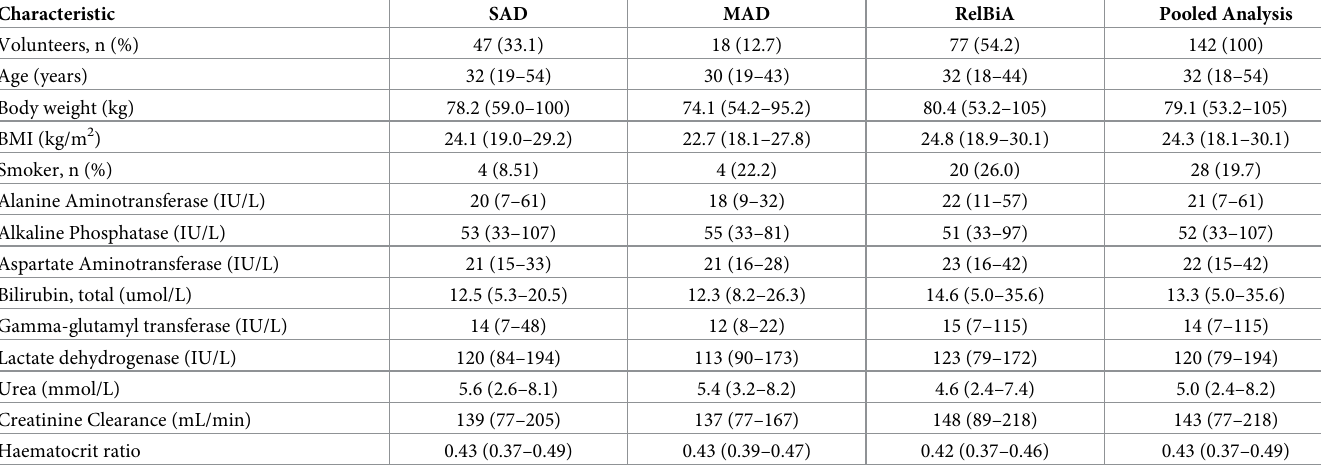
Table 2. Summary of baseline demographic and clinical data for the study populations contributing to the present analysis.